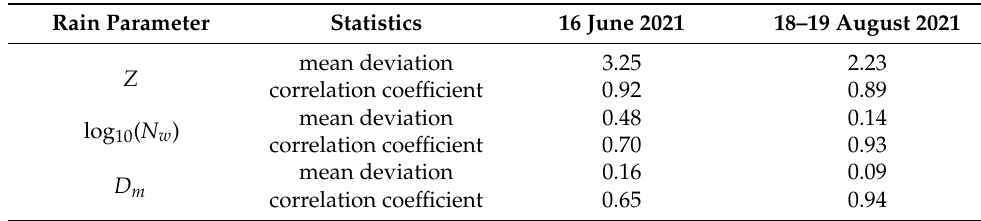
Figure 2. Time series of Z and DSD parameters of stratiform rain cases on 16 June 2021(UTC): ( a ) Z (dBZ), ( b ) log10( N w ) and ( c ) D m (mm) and on 18–19 August 2021(UTC): ( d ) Z (dBZ), ( e ) log10( N w ) and ( f ) D m (mm), detected by Distrometer (black line) and MRR (red line) on YJP station. Table 3. The mean deviations and correlation coefficients and of Z, log 10 ( N w ) and D m between MRR and disdrometer of two stratiform precipitation